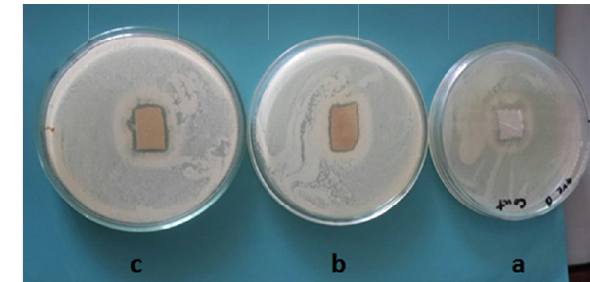
Fig. 8. Antibacterial effects of the untreated and AgNPs-treated silk fabrics on S. aureus (B) Gram-positive bacteria.